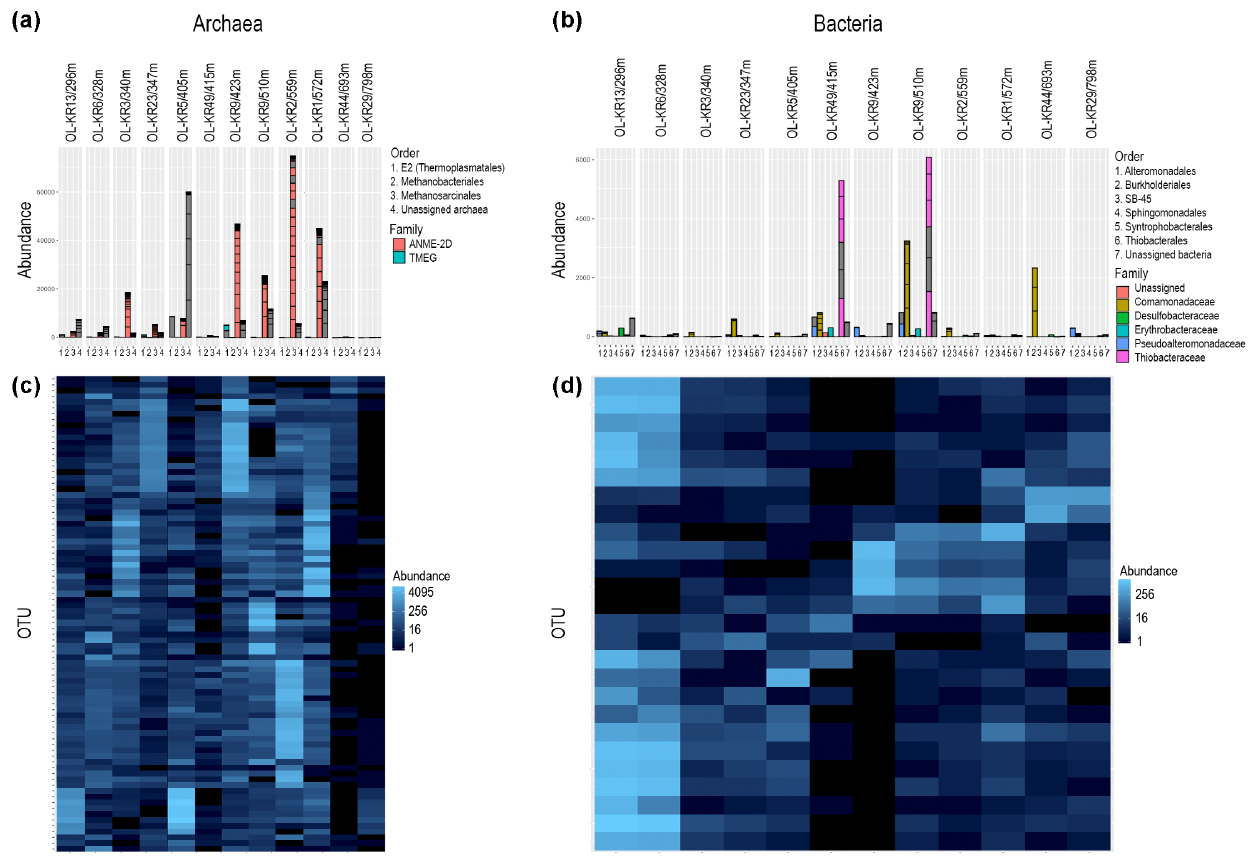
Figure 3. The core (a) archaeal and (b) bacterial community OTUs detected from at least 80% of the samples with heatmaps on the abundance of the (c) archaeal and (d) bacterial core community profiles. In (a) and (b) the OTUs are stacked in the columns according to the number of sequence reads, with the most abundant OTUs at the bottom of the columns. The OTU segments of the columns are coloured according to the family to which they belong. Each order is presented as a separate column for each sample.